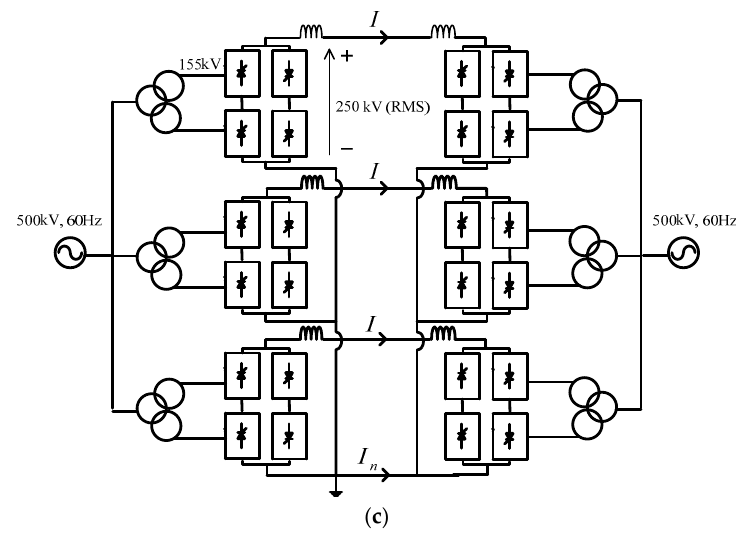
Figure 16. Configurations for valve and transmission line rating current: ( a ) High voltage direct current HVDC, ( b ) Single ‐ phase and two ‐ phase, ( c ) Three ‐ phase.